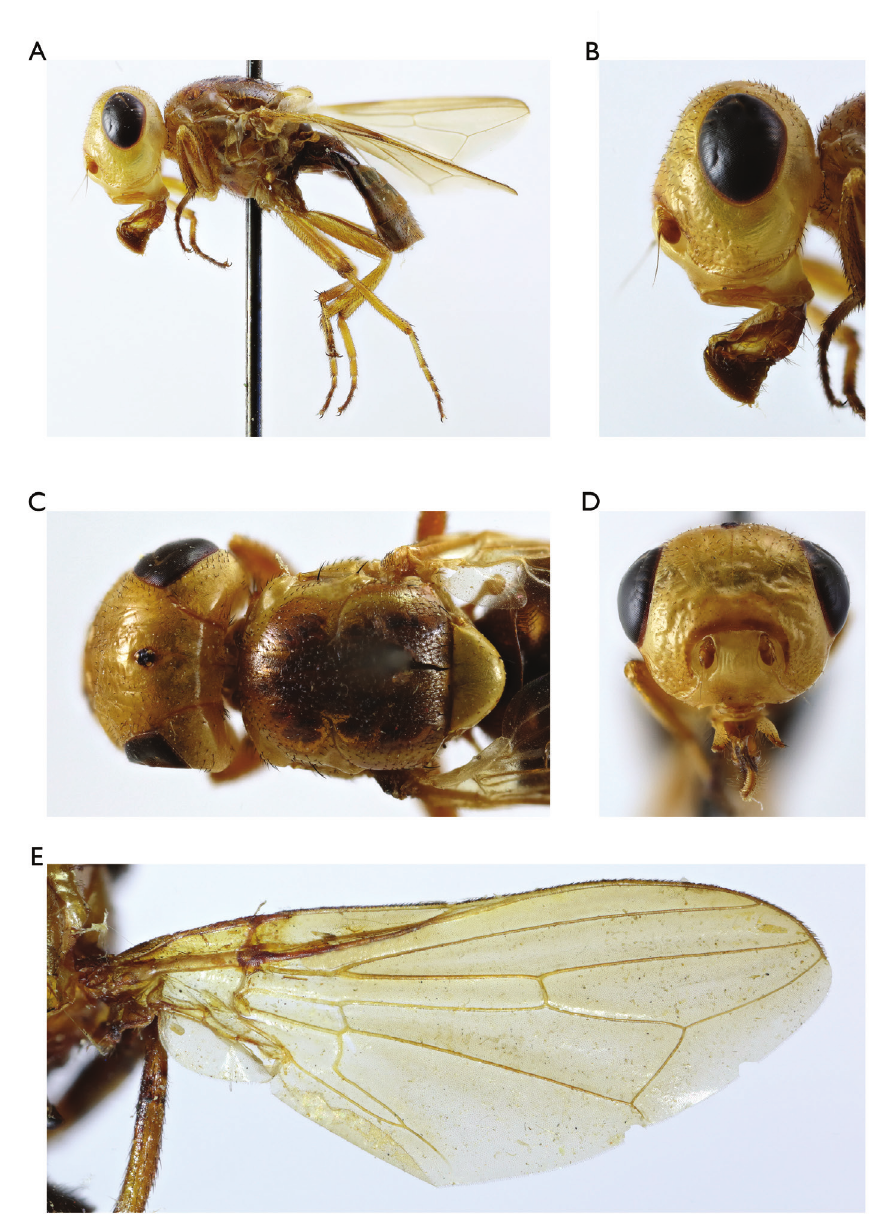
Figure 10. Timia testacea Portschinsky , 1891, male A habitus, lateral view B head, lateral view C head and thorax, dorsal view D head, anterior view E